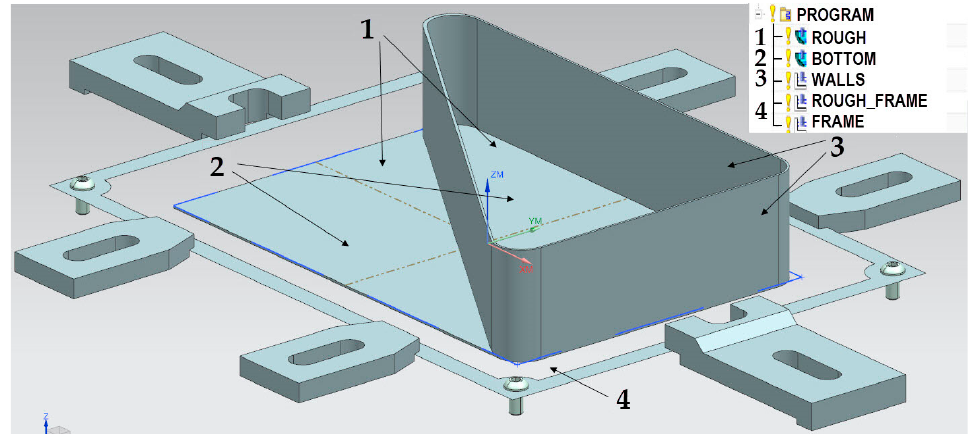
Figure 5. Stages of machining of the thin-walled element with walls arranged in a semi-open struc- ture.